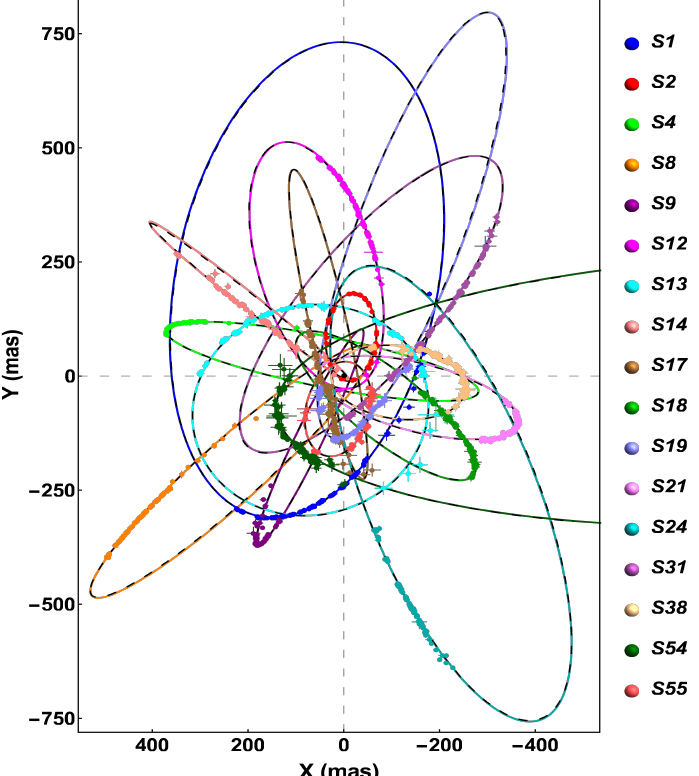
Figure 5. Best-fit orbits for the 17 best-resolved S-stars orbiting Sgr A*. It shows the projected orbit in the sky (see Appendix B), X vs. Y , where X is right ascension and Y is declination. The black dashed curves correspond to the BH model and the colored curves to the RAR model for mc 2 ≈ 56 keV fermions. Reproduced from [35] with the authors’